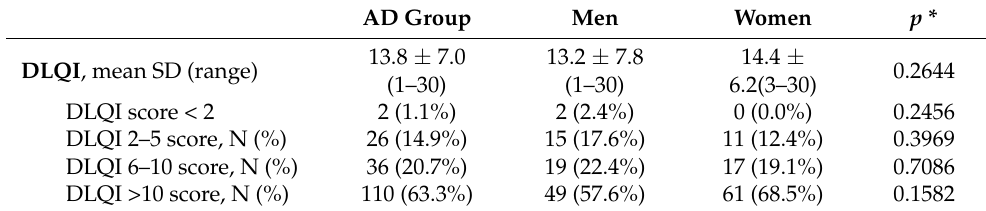
Table 3. Dermatology Life Quality Index (DLQI) score—continuous and categorical data of AD. AD Group